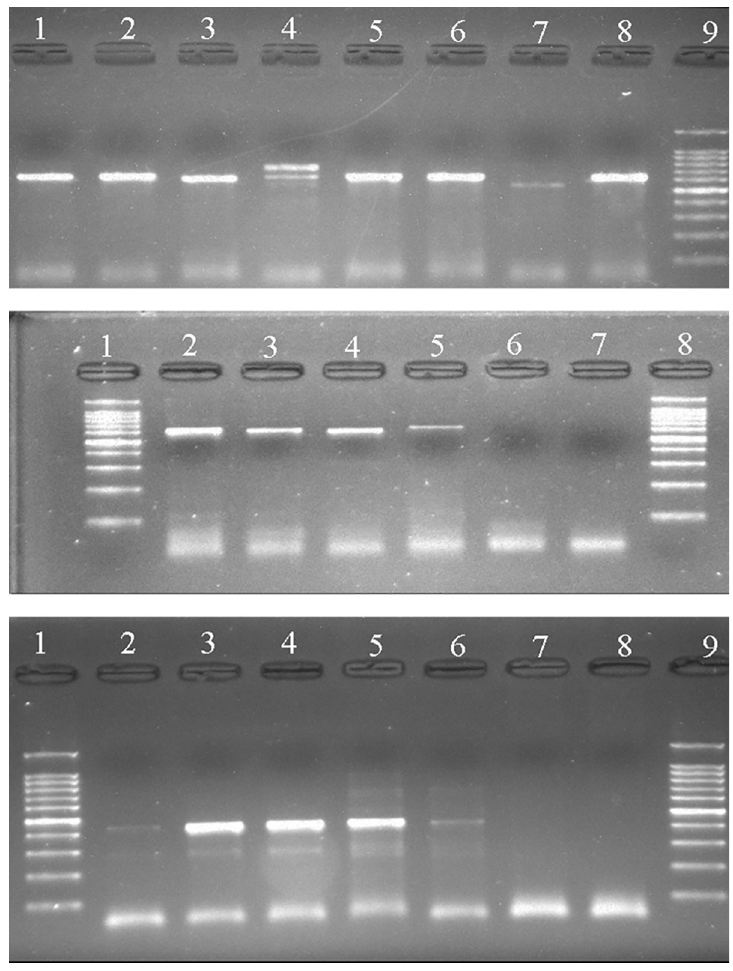
Fig 5. Gel representation of direct ITS and Madurella mycetomatis -specific PCR. (A) PCR of the ITS region using ITS4/ITS5 primers. A double band was noted in sample 4; (B) PCR of the ITS region. Lanes: 1 DNA ladder, 2 M . mycetomatis , 3 M . tropicana , 4 M . fahalii , 5 Sphaerulina rhododendricola , 6 and 7 are negative; (C) PCR using Madurella mycetomatis -Specific primers. Lanes: (2–6) M . mycetomatis , 7 M . tropicana , 8 M . fahalii